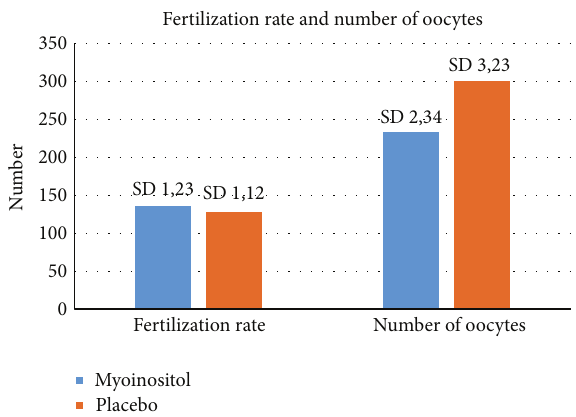
Figure 2: Relation between the myoinositol treatment and the fertilization rate in both groups. Higher rates ( 𝑝 < 0.05 ) were observed in the myoinositol group in comparison to the placebo group.